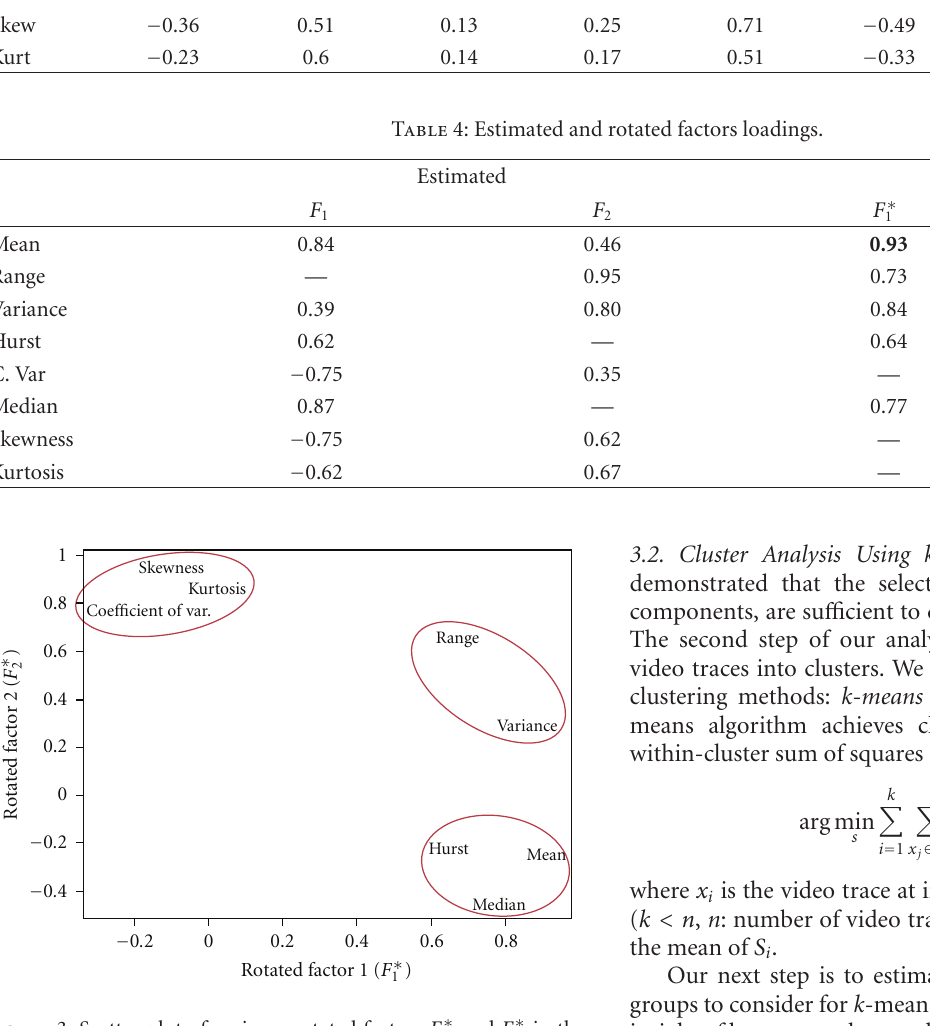
Figure 3: Scatter plot of varimax rotated factors F ∗ 1 and F ∗ 2 in the space of the two principal